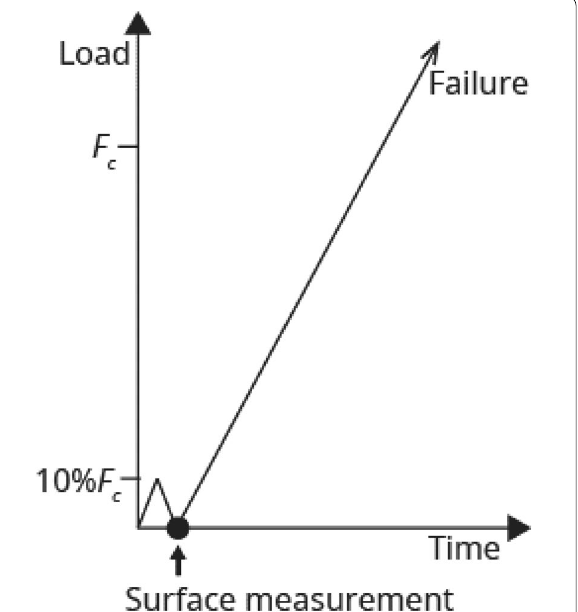
Fig. 3 Loading and surface measurement cycle of cedar and cypress specimens